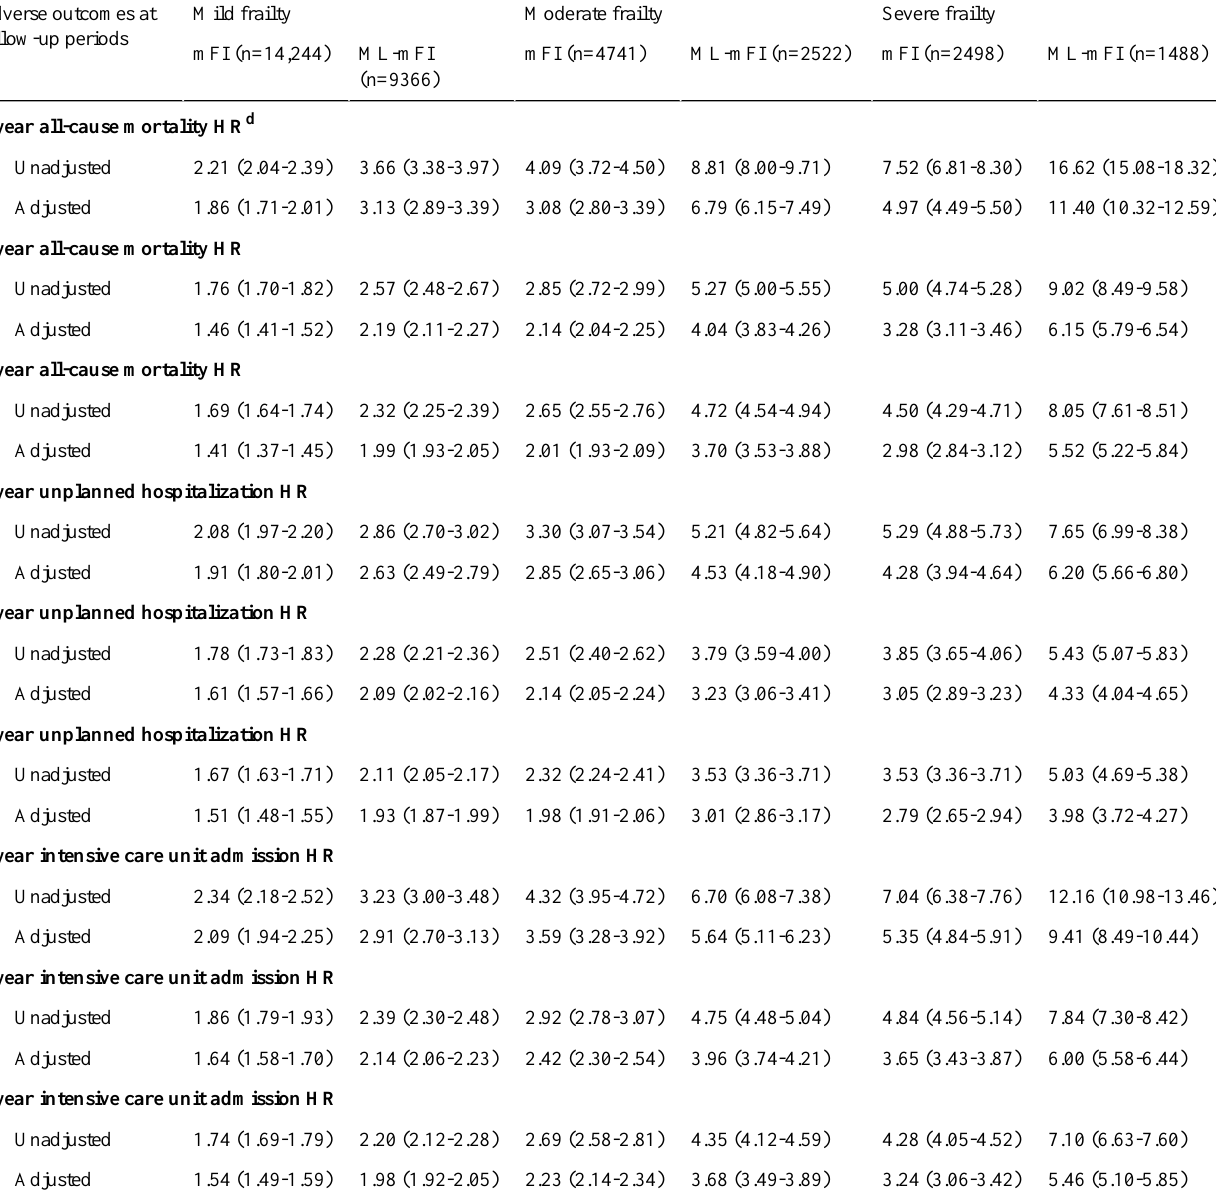
Severe frailtyModerate frailtyMild frailtyAdverse outcomes at